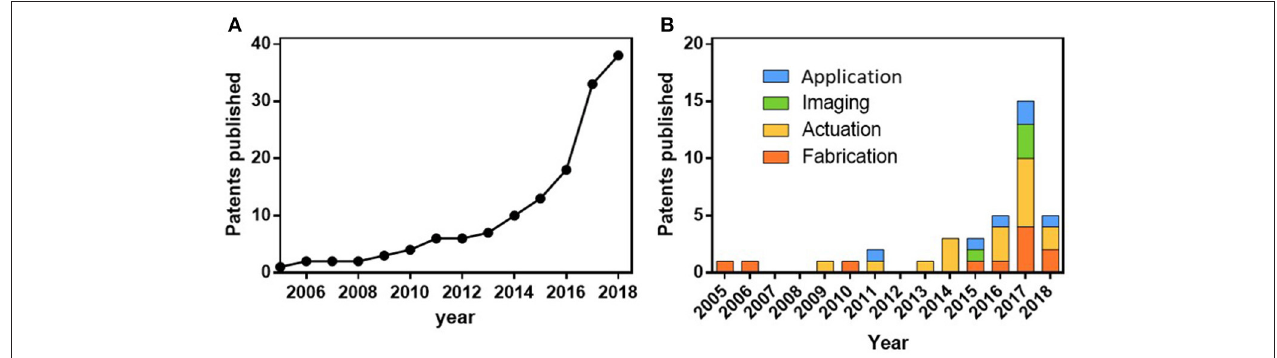
FIGURE 6 | Overview of micro/nanorobotics intellectual property, as described in section Intellectual Property and Commercialization. (A) Accumulative published patents in the last years. (B) Graph illustrating patents considering the application per year.